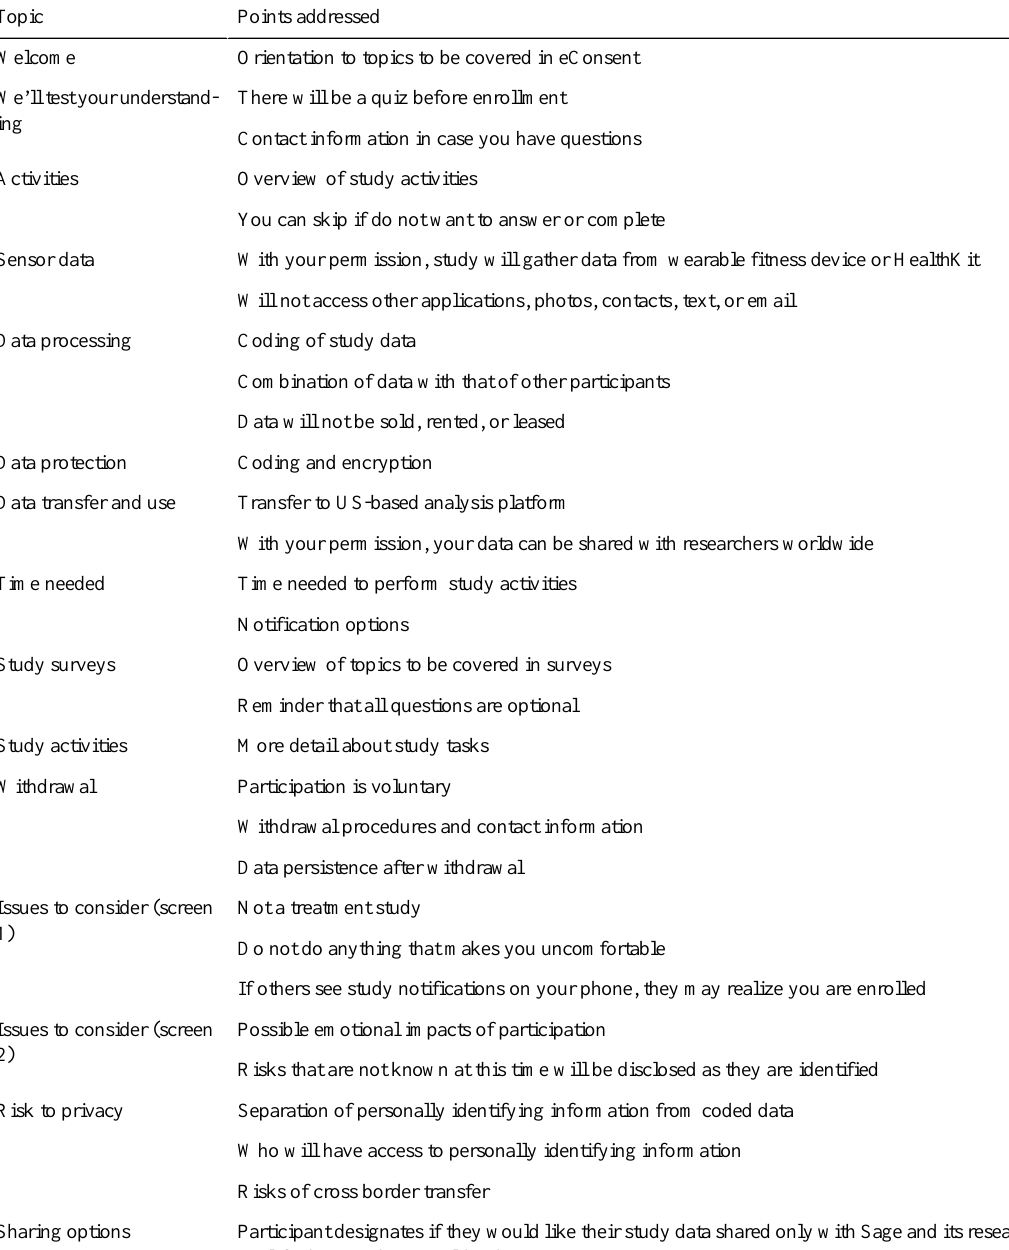
Table 1. mPower electronic informed consent (eConsent) content. Points